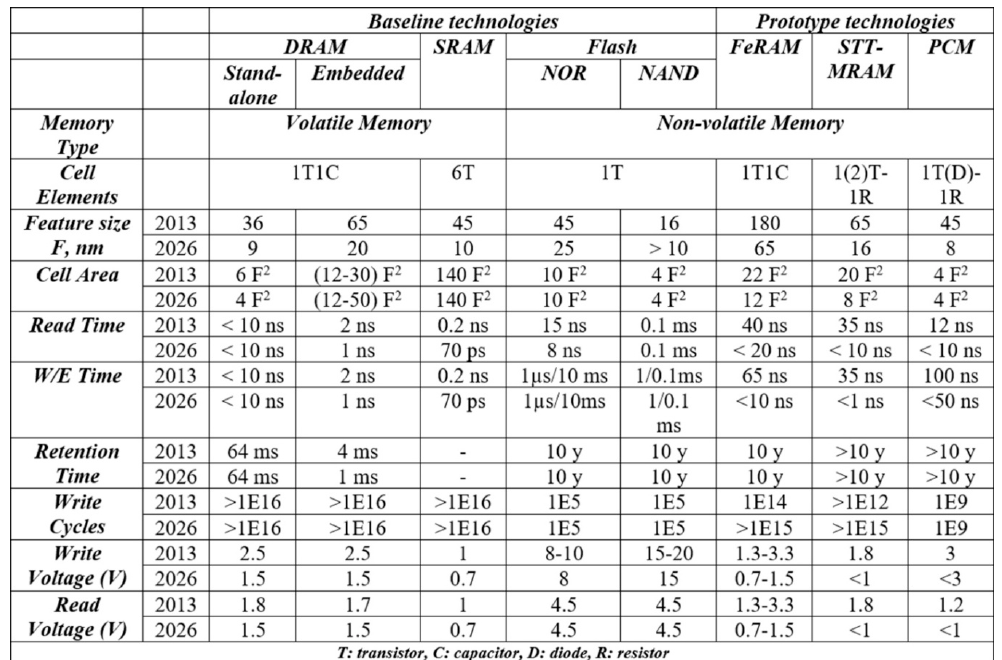
Figure 2. Performance comparison of current baseline and prototype memory technologies [3].